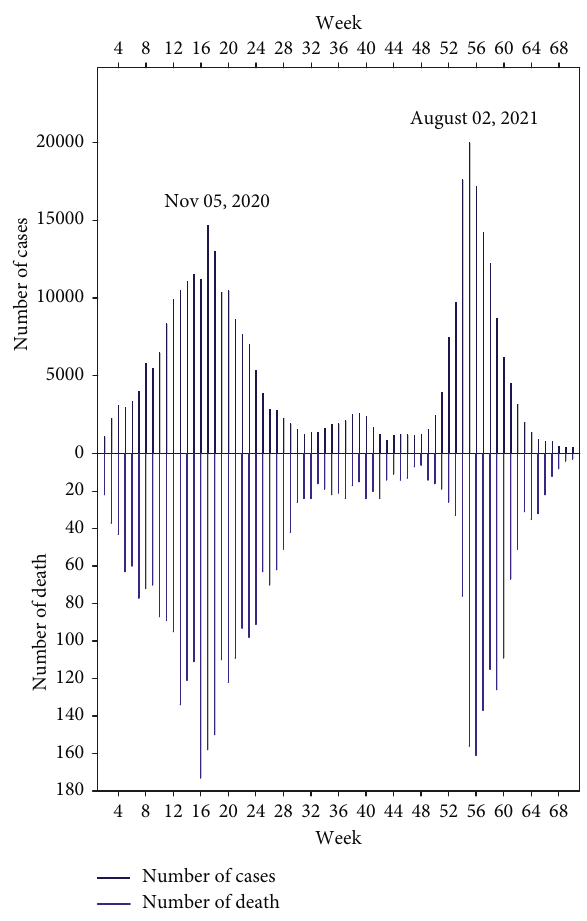
Figure 2: The weekly evolution of deaths and confirmed cases by SARS-CoV-2 in the Casa-Settat region from July 22, 2020, until 30/